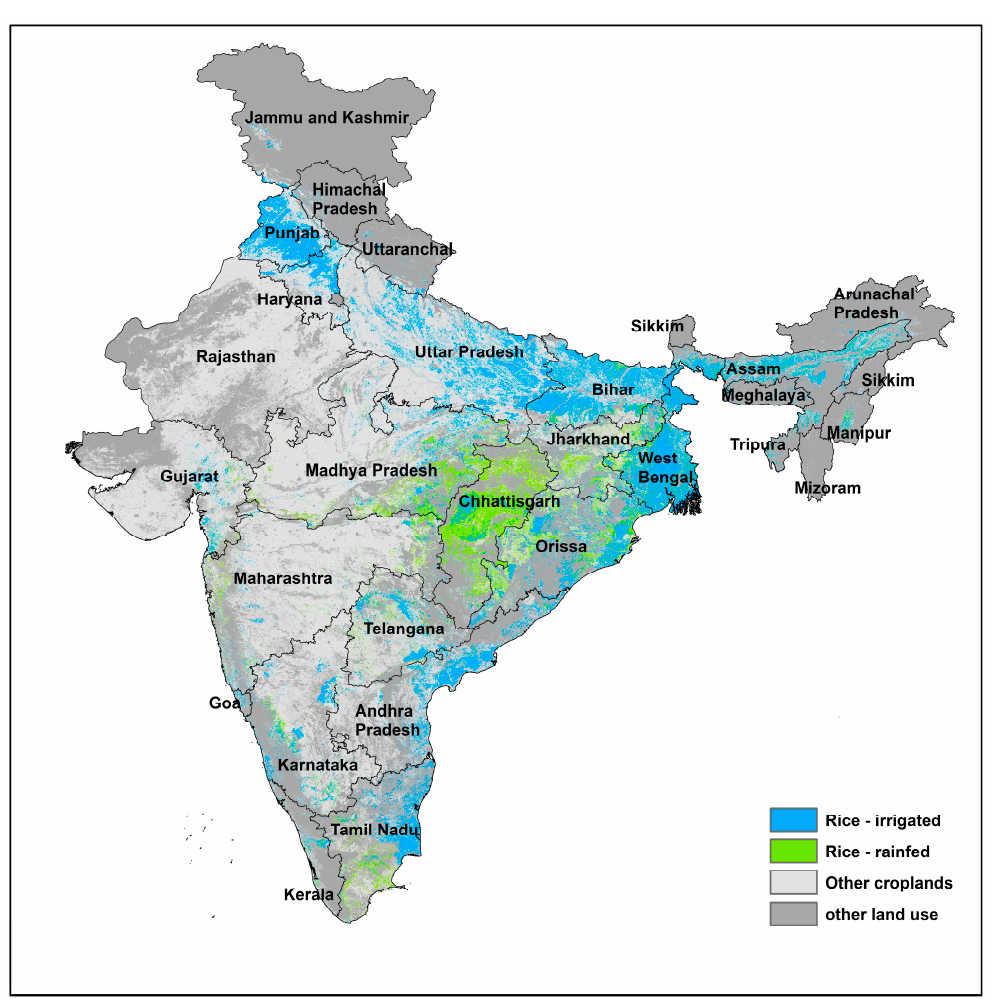
Figure 1. Map of India and delineation of the Indian States. Locations mostly devoted to rice cultivation are highlighted in colors [1]. Light blue indicates the presence of irrigated fields (at least one cycle), either from hydraulic structures, canal, small reservoirs/tanks, or ground water. Green indicates rainfed regions.